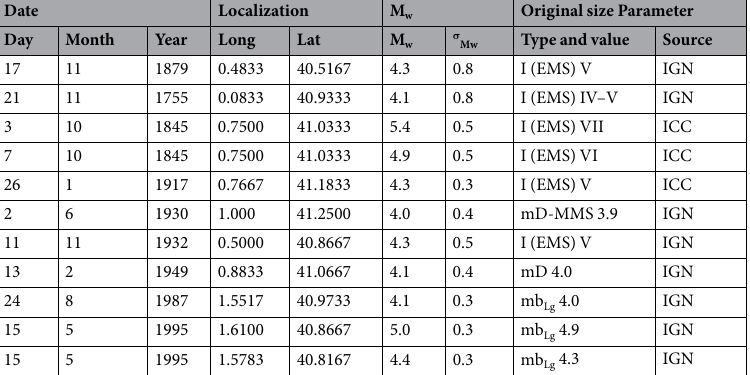
Table 2. Location and size parameters corresponding to earthquakes with epicenters in the area of 100 km (M w ≥ 4.0) around Castor